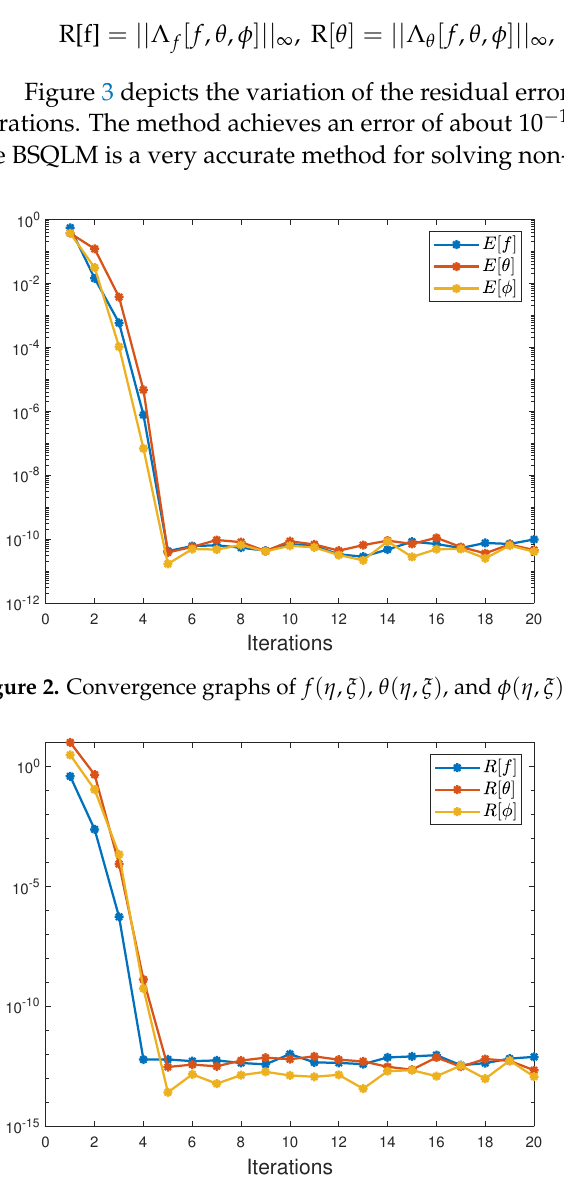
Figure 3. Accuracy graphs of f ( η , ξ ) , θ ( η , ξ ) , and φ ( η , ξ ) . The effects of the ratio of relaxation to retardation times parameter λ on the fluid velocity, temperature and concentration are depicted in Figures 4–6. It is observed that enhancing λ results in an increase in the fluid velocity near the vertical plate but the velocity decreases towards the free stream. Generally, the fluid temperature and concentration are slightly depressed as λ is increased. The ratio of relaxation to retardation times is inversely proportional to the retardation time, which is the time the material require to react to deformation. An increase in λ signifies weaker retardation time. Figures 7–9 depict the influence of the concentration to thermal buoyancy parameter K on the fluid velocity, temperature, and concentration. From Figure 7, it is noted that the momentum boundary thickens near the plate and then diminishes as the free-stream is approached. Both the temperature and solute concentration distributions are reduced with increasing K as displayed in Figures 8 and